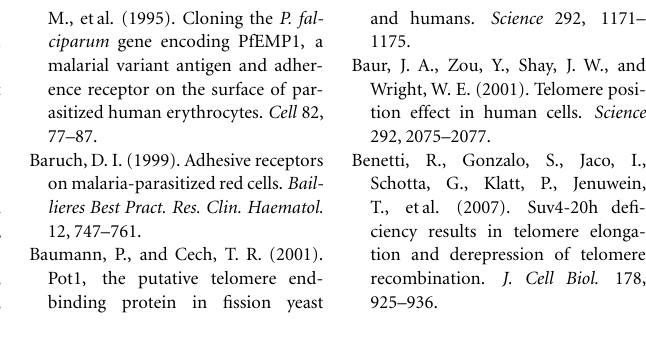
FIGURE 6 |The organization of vlsE and the array of silent vls genes on lp28 linear plasmid of B. burgdorferi . The vls1 gene (moss colored arrow) is expressed from the vlsE expression site next to the telomere (pink arrows). The direct repeats (barred boxes) and the unique regions (green boxes)